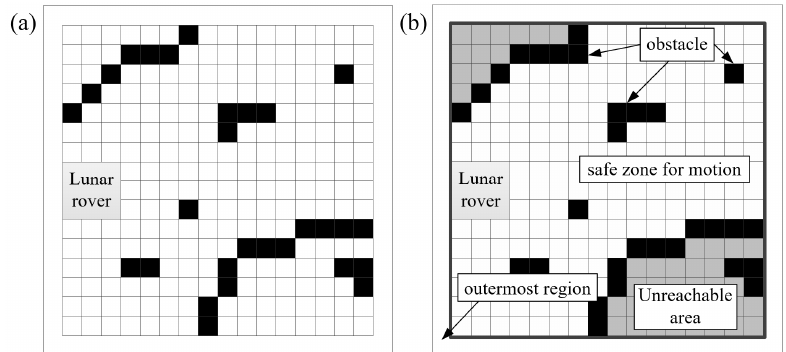
S of the lunar rover. ( a ) The passable region by white grids. ( b ) The Figure 4. Schematic of the fit constituted actual safe zone. constituted actual safe